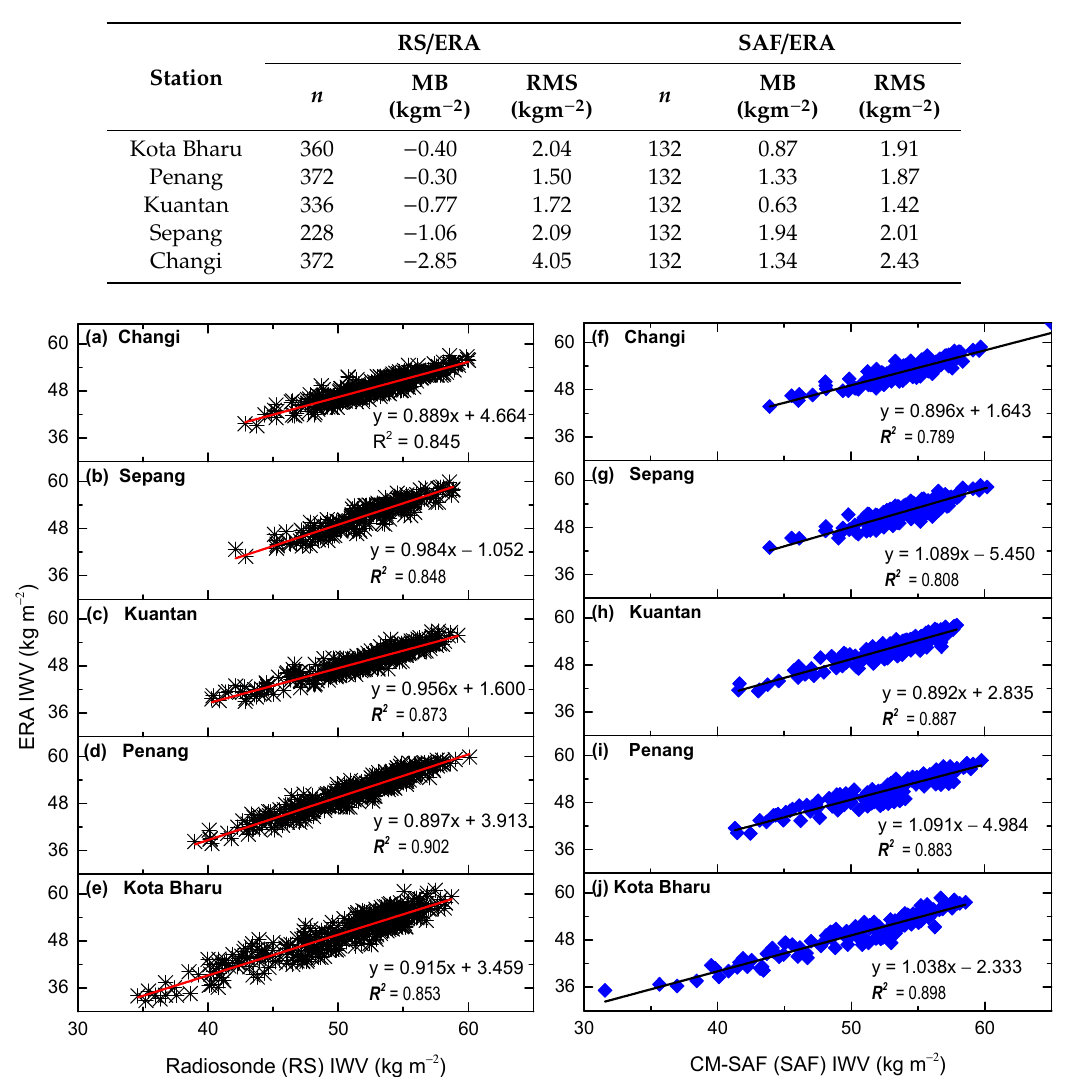
Table 2. Statistical proximity between IWV (Integrated water vapour) from ERA (1988–2018) when compared to RS (1988–2018) and SAF (2001–2011) IWV observations in Peninsular Malaysia. n is number of observations.